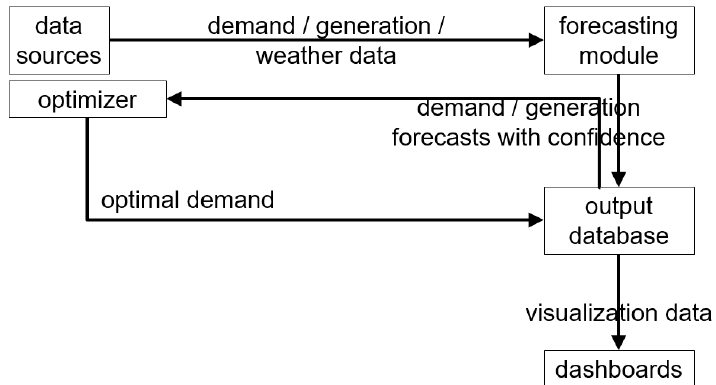
Figure 1. High-level architecture of the forecasting and optimization